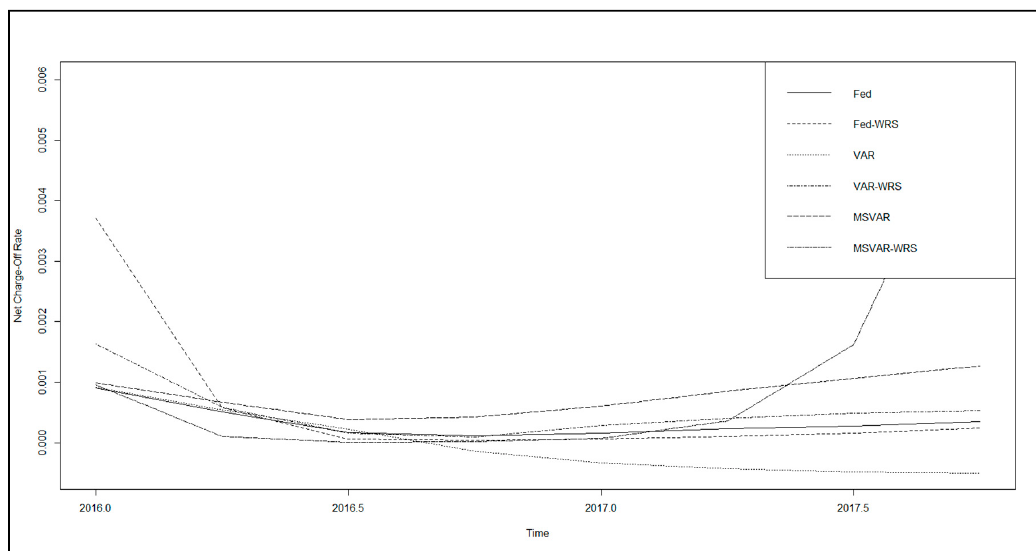
Figure 9. Kullback–Leibler relative entropy worst-case loss for model risk quantification plot—unemployment rate and BBB corporate bond yield (FDIC SDI Report, Federal Reserve Board 4Q91–4Q15 and Jacobs (2018) models).